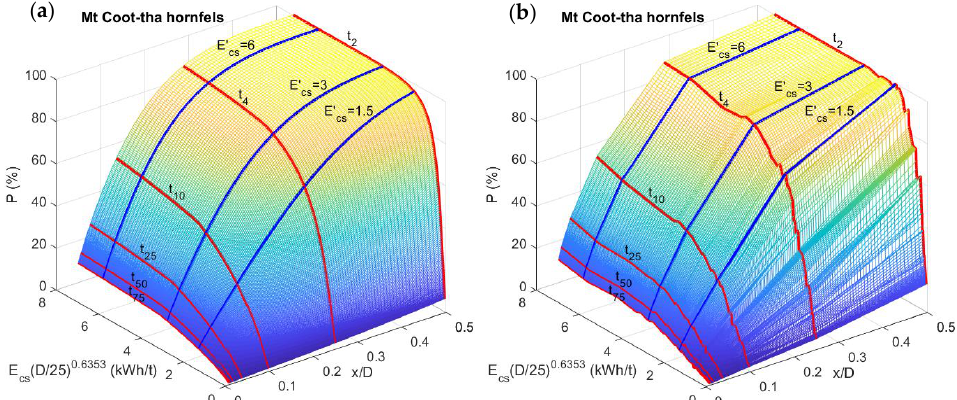
Figure 6. Breakage surfaces for Mt Coot-tha hornfels as predicted from the double fan fits ( a ) and the Banini [19] data ( b ). The lines shown are size distributions for a scaled crushing energy of 1.5, 3 and 6 kWh/t (blue lines), and the breakage indexes t 2 , t 4 , t 10 , t 25 , t 50 and t 75 (red lines) ([21], Figure 15).